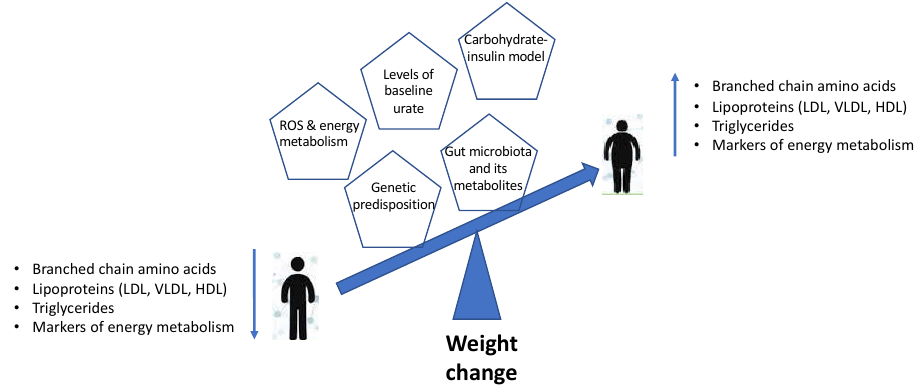
Figure 1. Schematic representation summarising the metabolomic profiles and models associated with weight change.